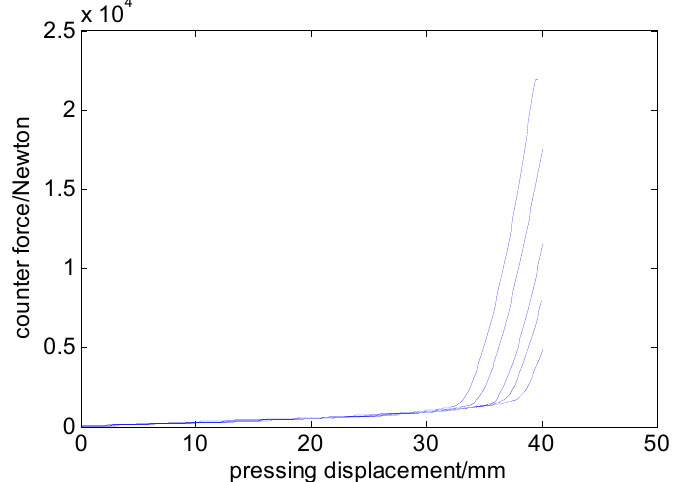
Figure 8. The strong inconsistency of counter forces in different tests when no ‘relaxing time’ was assigned.